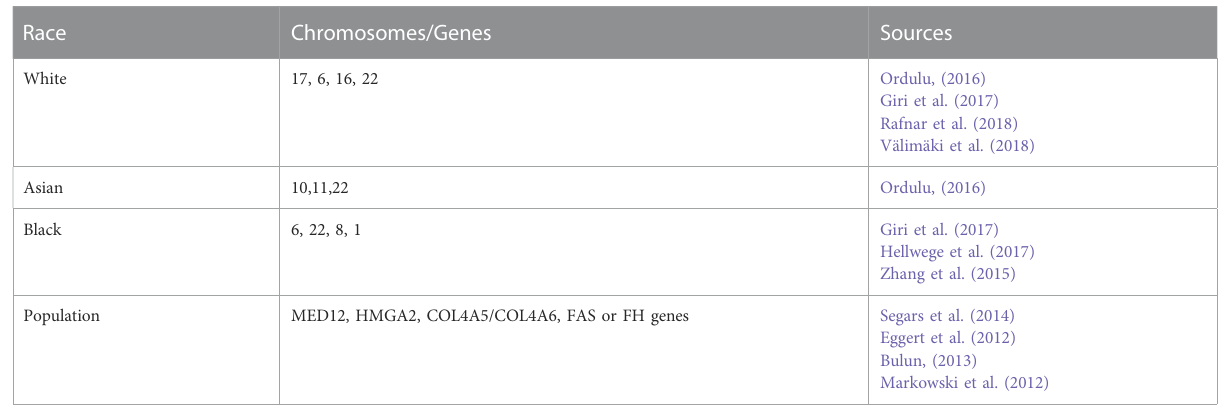
TABLE 2 Chromosomal associations by